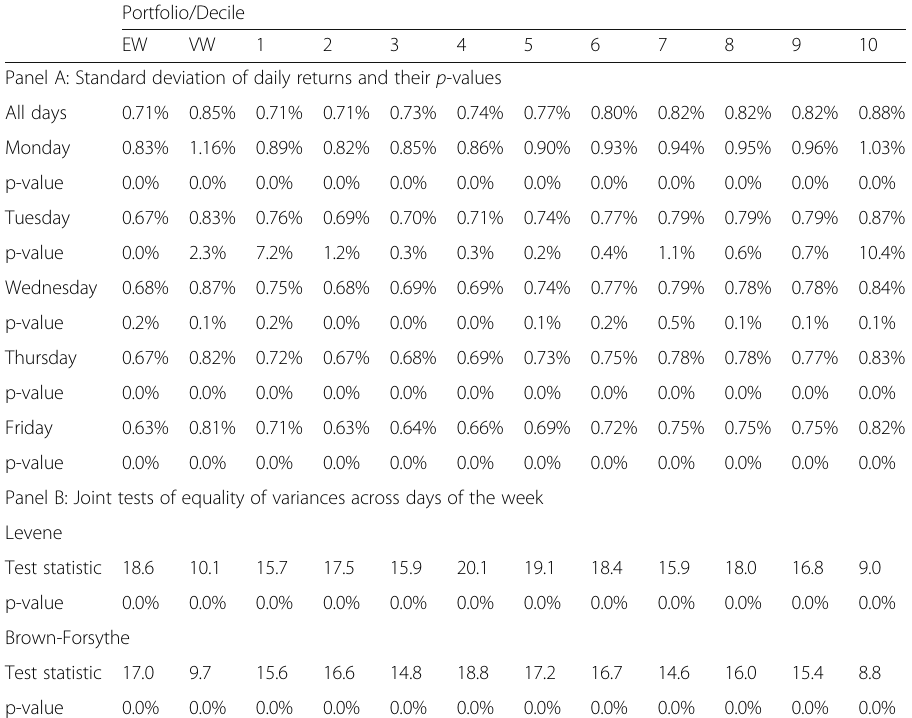
Table 1 Are variances equal across days of the week? Portfolio/Decile Panel A: Standard deviation of daily returns and their p -values All days